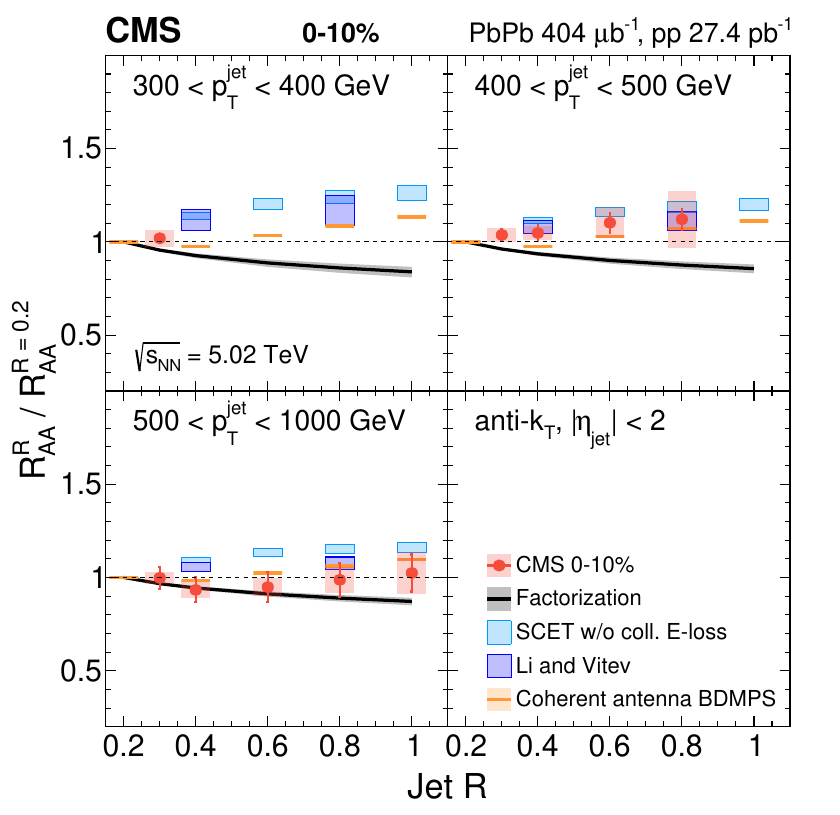
for jets with | η jet | < 2 . 0 as a function of R for R = 0 . 3 – Figure 14 . The double ratio R R /R R =0 . 2 AA AA 1 . 0 with respect to R = 0 . 2 , in various p jet ranges for the 0–10% centrality class. The statistical T uncertainties of data are shown as the vertical lines, whereas the systematic uncertainties are shown as the shaded boxes. The width of the boxes carries no meaning. The calculations based from Scet (sky blue and navy blue), coherent antenna bdmps (orange) and, jet factorization (gray) formalisms, shown with the colored bands and boxes, are compared to the